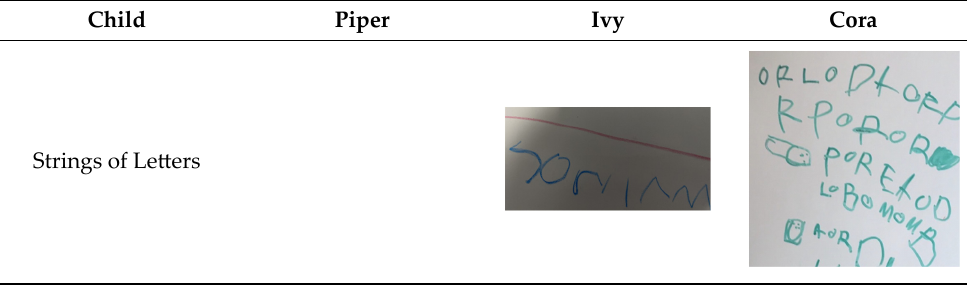
Table 2. The Emergent Stage.